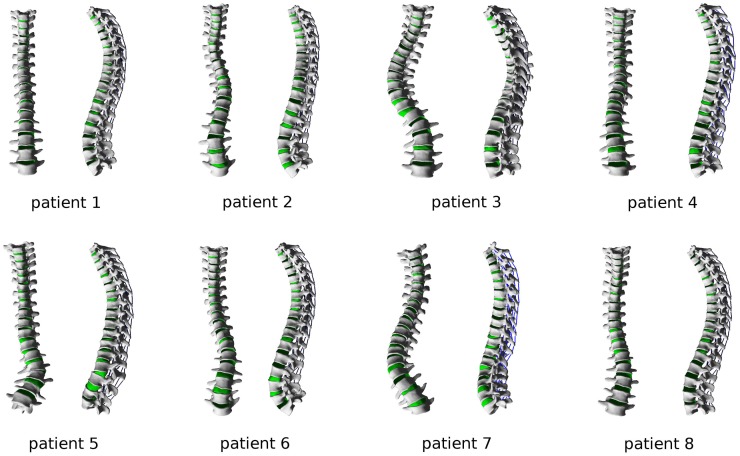
Finite element meshes of the thoracolumbar spines of eight patients suffering from adolescent idiopathic scoliosis, ranging from mild to severe grades.